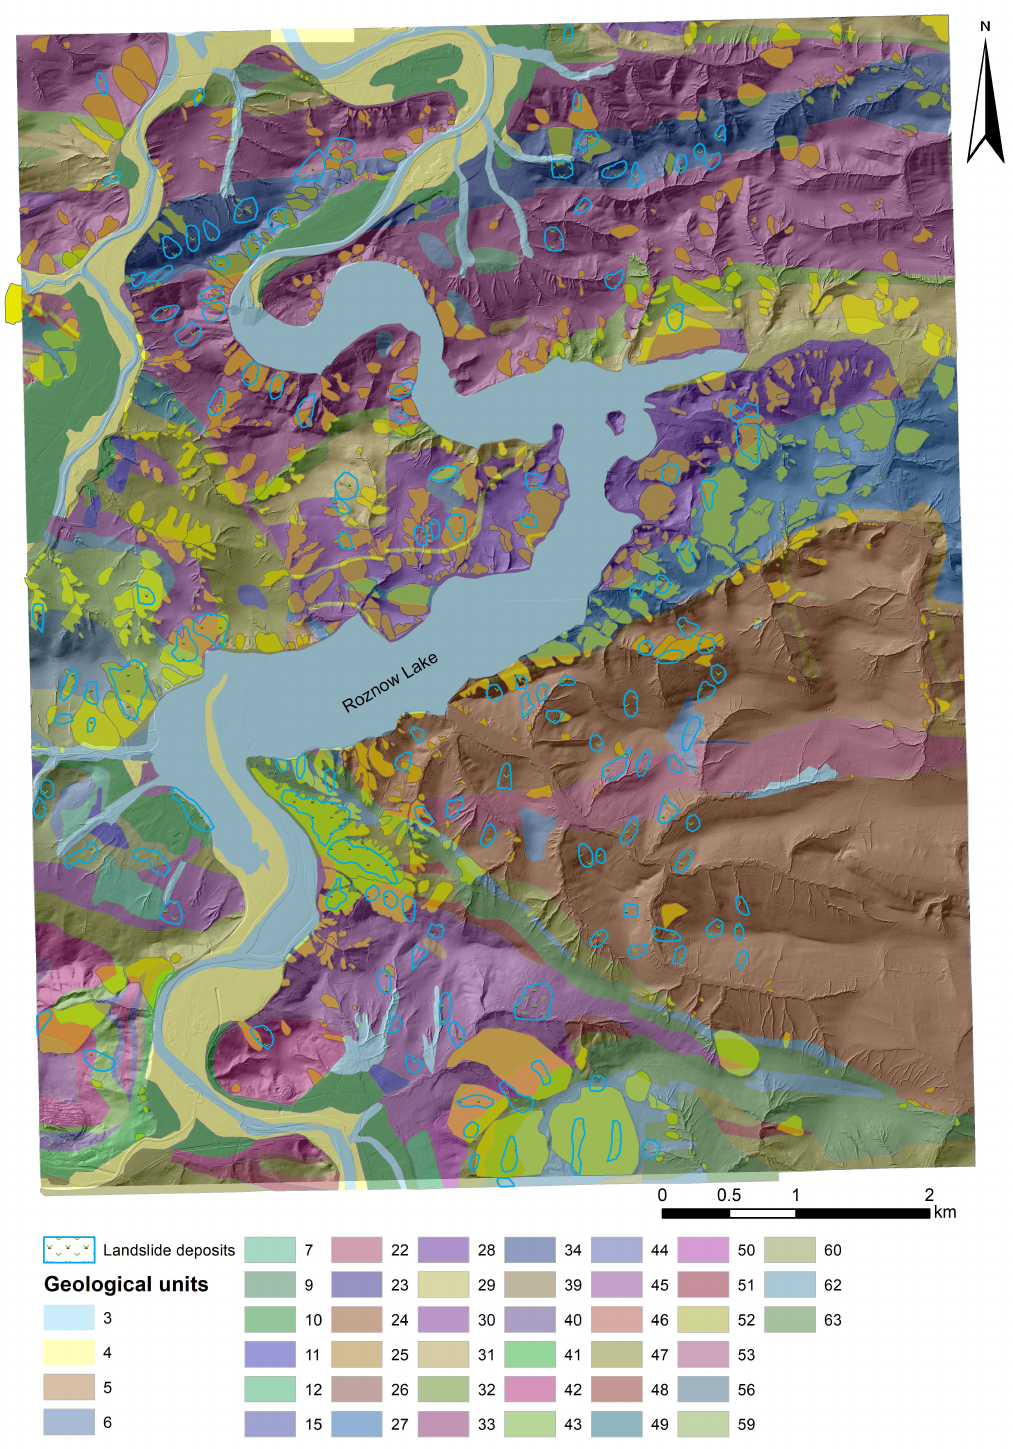
Figure A2. Geological map of the study